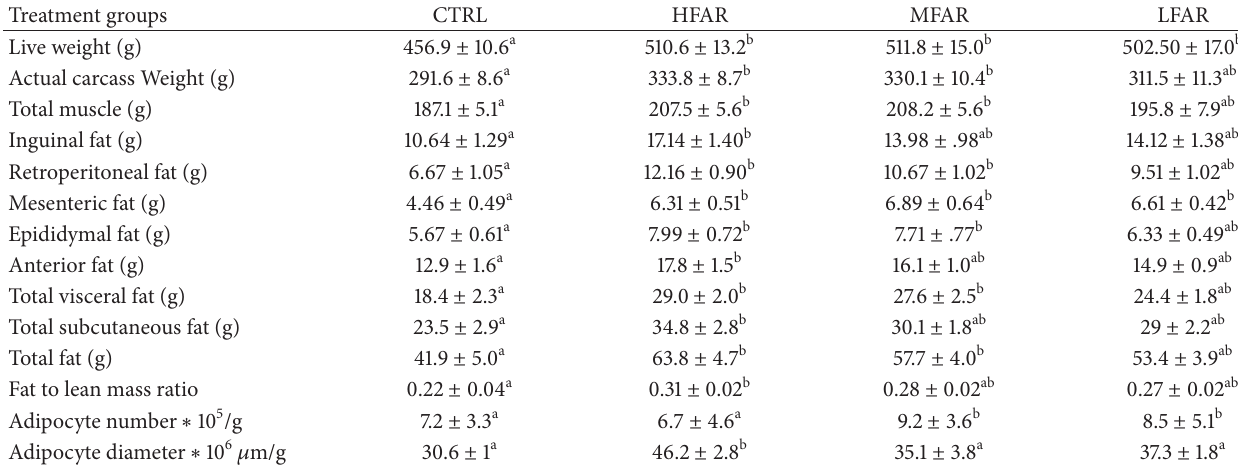
Table 3: Body composition, fat accretion, and inguinal fat cellularity of rats (Mean ± SEM). Treatment groups